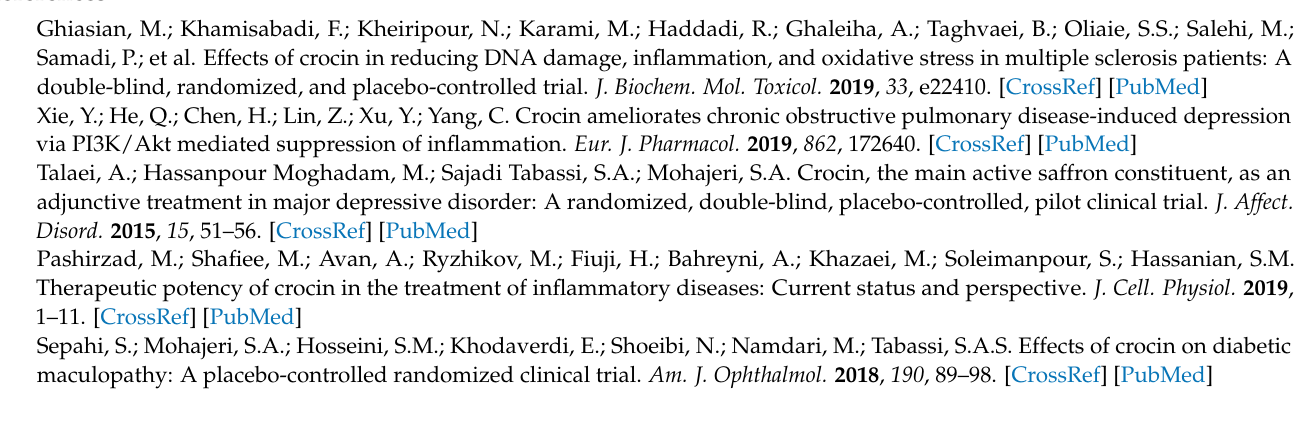
Supplementary Materials: The following are available online. Figure S1: 400 MHz 1 H-NMR spec- trum of compound 1 (in DMSO- d 6 ); Figure S2: 100 MHz 13 C-NMR spectrum of compound 1 (in DMSO- d 6 ); Figure S3: 400 MHz 1 H-NMR spectrum of compound 2 (in DMSO- d 6 ); Figure S4: 100 MHz 13 C-NMR spectrum of compound 2 (in DMSO- d 6 ); Figure S5: ESI-MS spectrum of compound 1 ; Figure S6: ESI-MS spectrum of compound 2